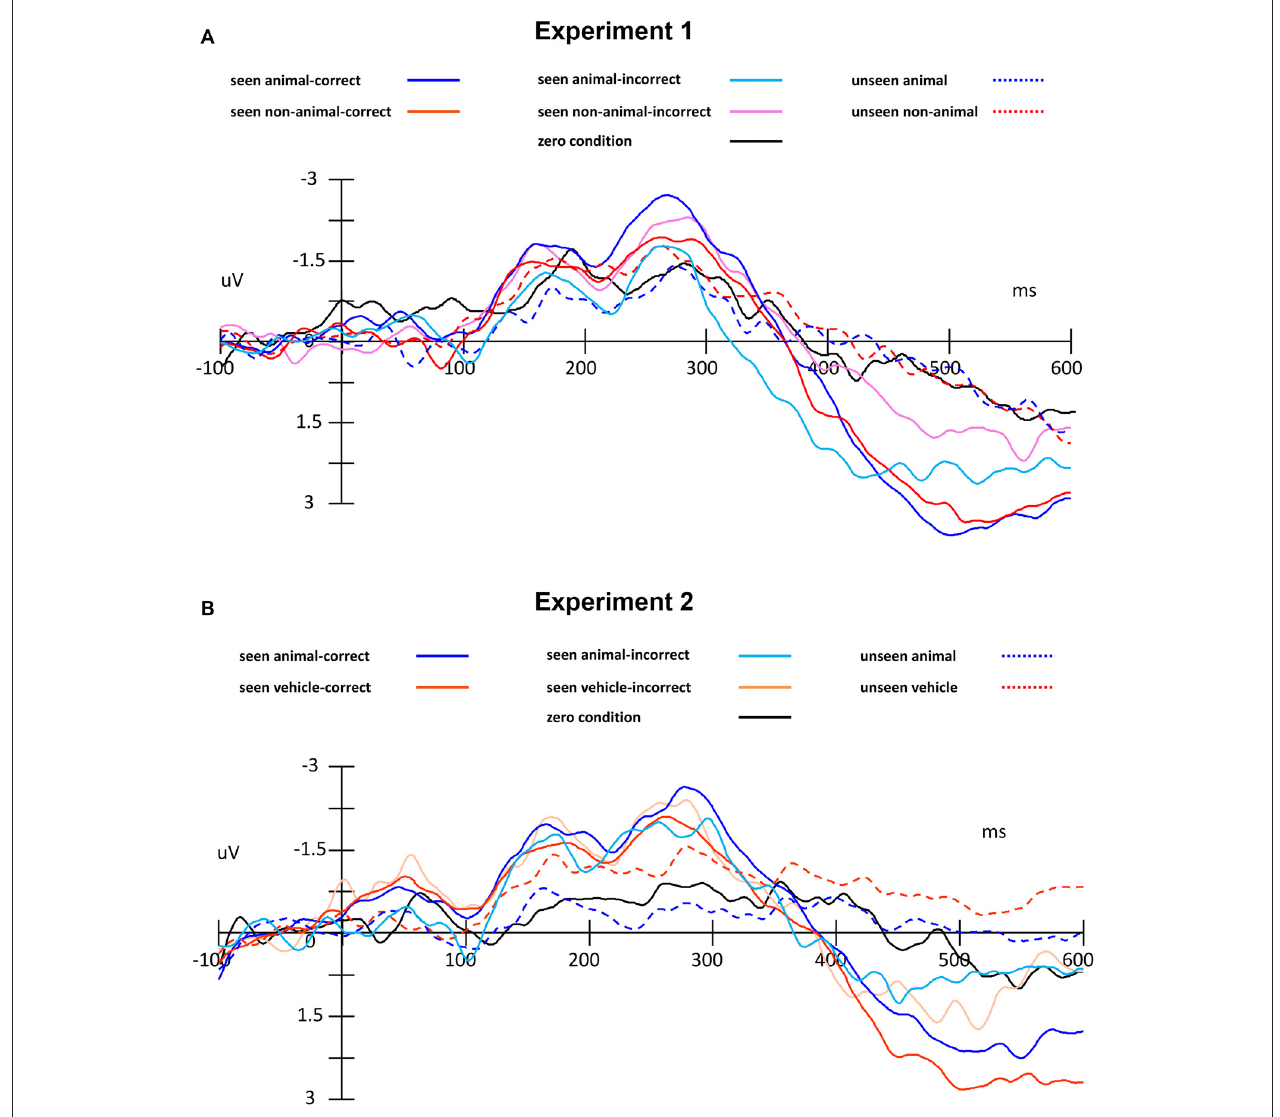
FIGURE 5 | ERP traces, separated by condition, including zero condition (catch trials without target) and error trials. (A) Experiment 1, (B) Experiment